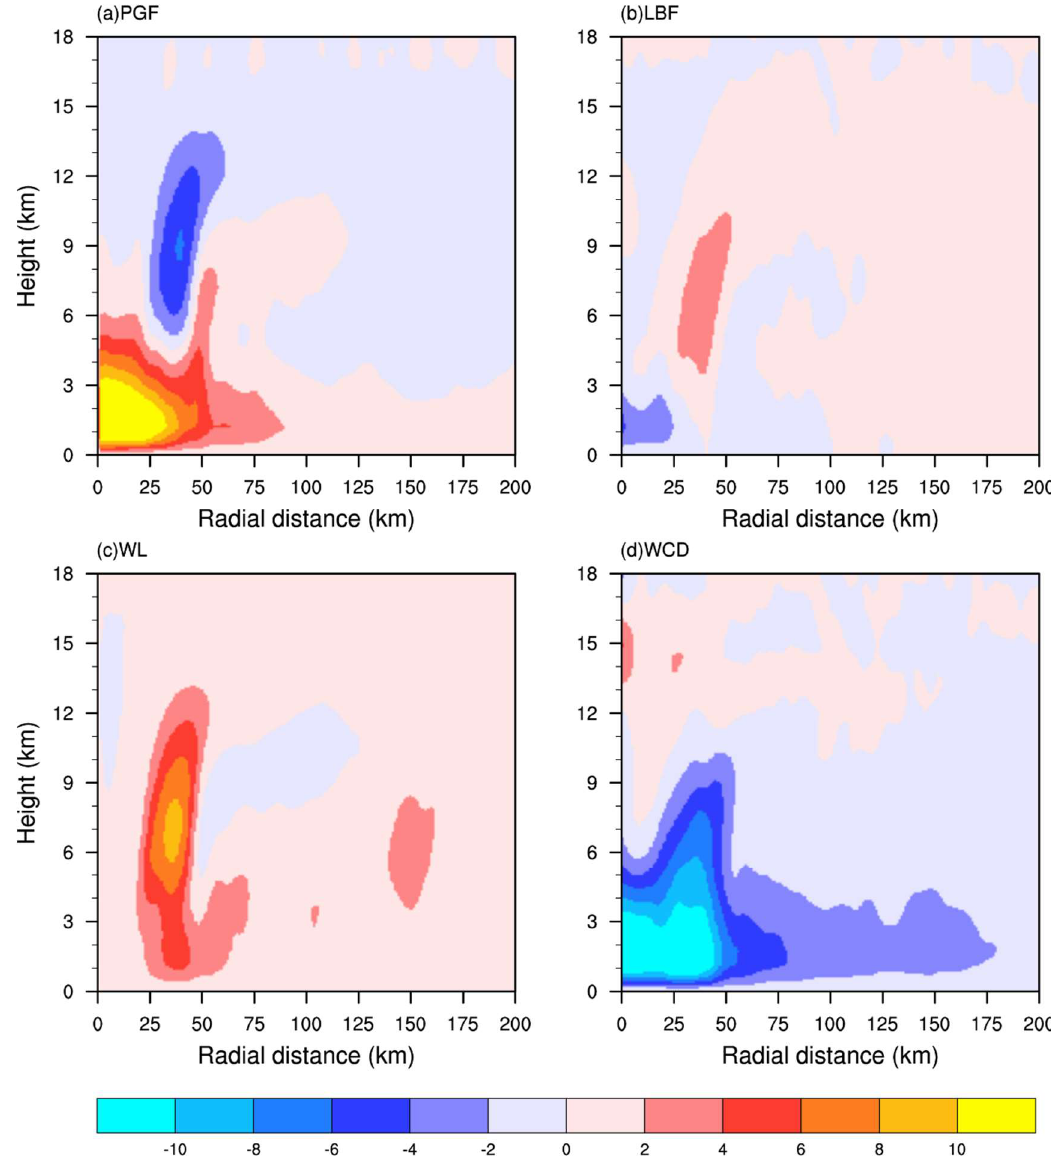
Figure 8. As in Figure 7, but for CTRL-HY.